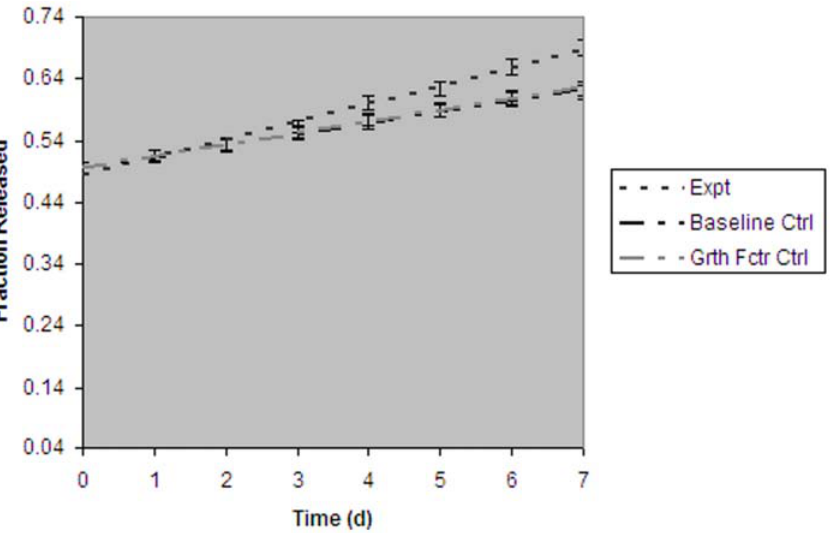
Figure 1. EGF in solution increases rate of encapsulated actinomycin D release. Percentage (expressed as fraction released) of encapsulated actinomycin D released as assessed by 1 H NMR spectroscopy. Baseline Ctrl, actinomycin D-encapsulating MRBLs without growth factor added to solution. Grth Fctr Ctrl, actinomycin D-encapsulating MRBLs with VEGF added to solution. Expt, actinomycin D-encapsulating MRBLs with EGF added to